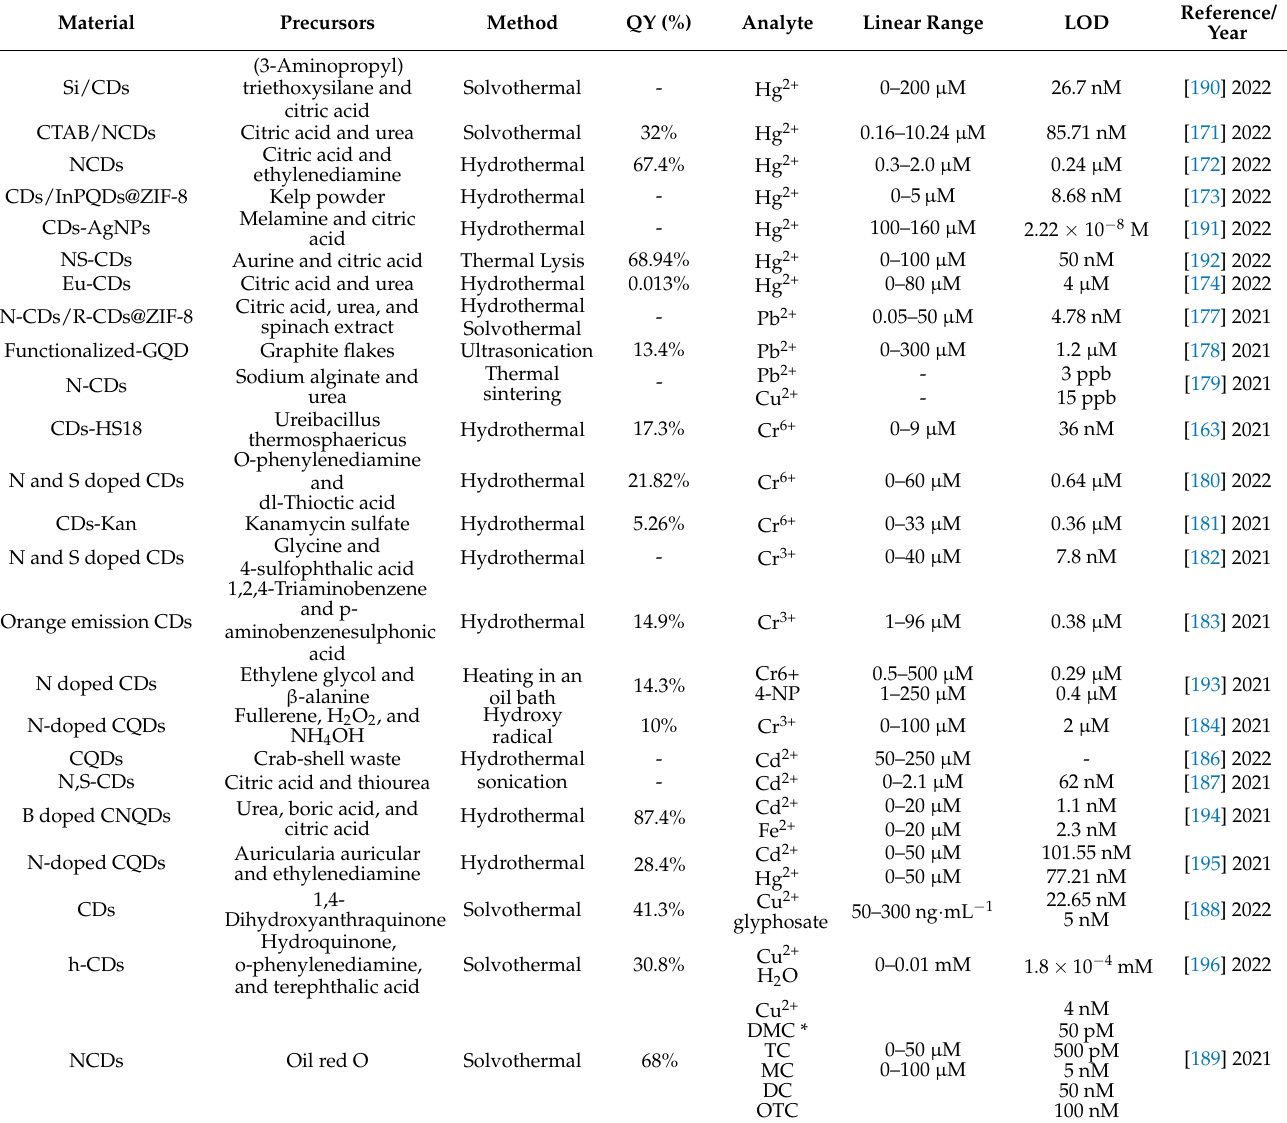
Table 2. Precursors, synthesis methods, quantum yields, target analytes, linear ranges, and detection limits of various CDs for the sensing